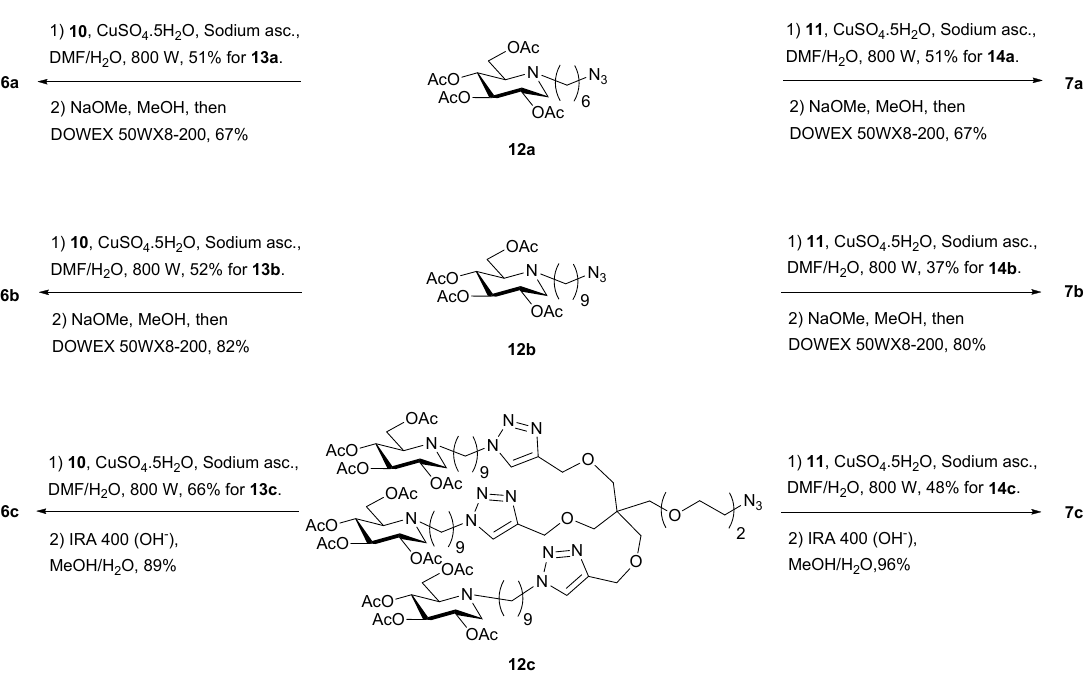
Table 1. Inhibition constants, relative inhibition potencies, and relative inhibition potencies per inhibitory unit of iminosugar clusters and monovalent references against JB α